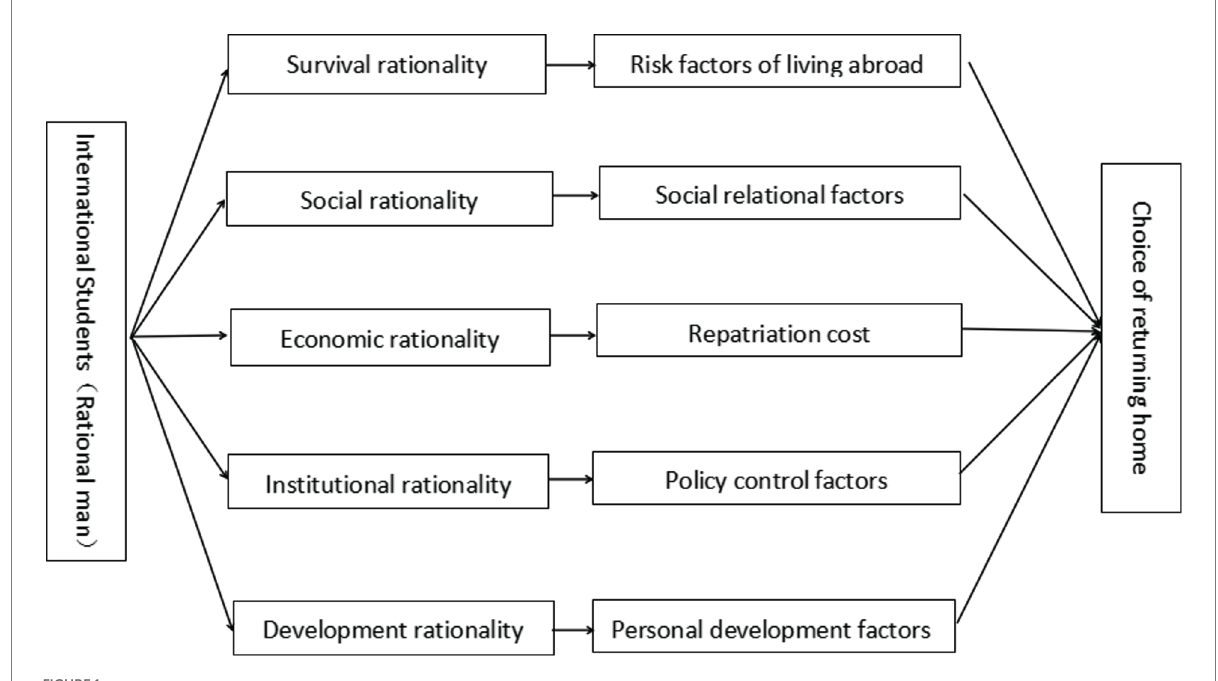
FIGURE 1 Model of influencing factors of overseas students’ choice of returning